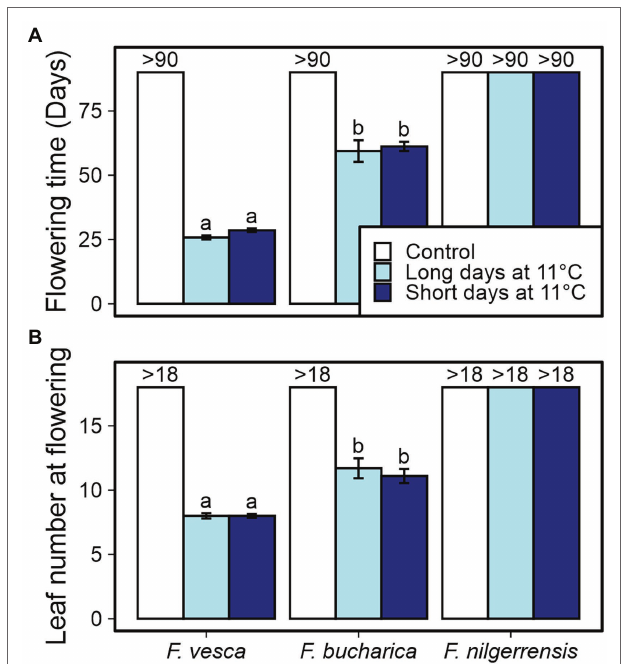
FIGURE 5 | Flowering characterization of three diploid strawberry species grown under SDs or LDs at 11 ° C. Number of days (A) and number of leaves developed (B) until the first flower opened. Stolon-propagated plants were grown in LDs (18-h) or SDs (12-h) at 11 ° C for 6 weeks followed by LDs (18-h) at 18 ° C. Control plants were grown in LDs (18-h) at 18 ° C from the beginning of the experiment. Flowering time was recorded every other day, starting after the treatments. Error bars represent the SEM ( n = 10) and different letters indicate significant differences calculated by ANOVA and Tukey’s test ( p < 0.05). For plants that remained vegetative, the number of days recorded (>90) or the number of leaves observed (>18) is